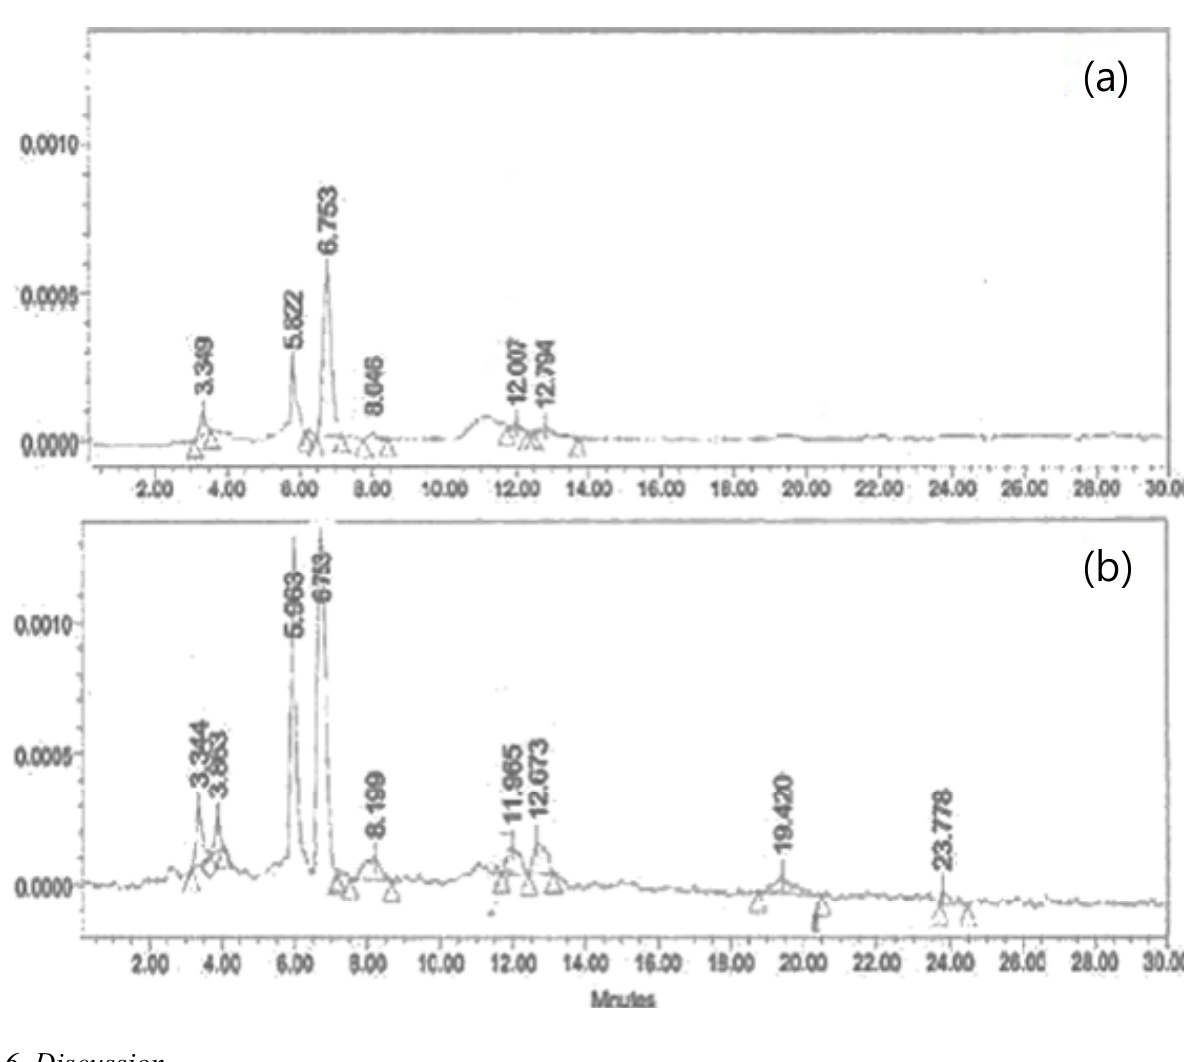
Figure 6. Comparison of the HPLC chromatograms for the water extract of S. maxima cultivated in seawater ( a ) and deep-sea water ( b